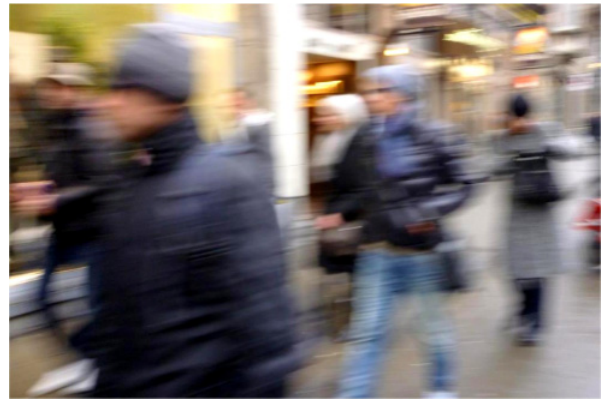
Figure 3. The indefinite citizen. Source: